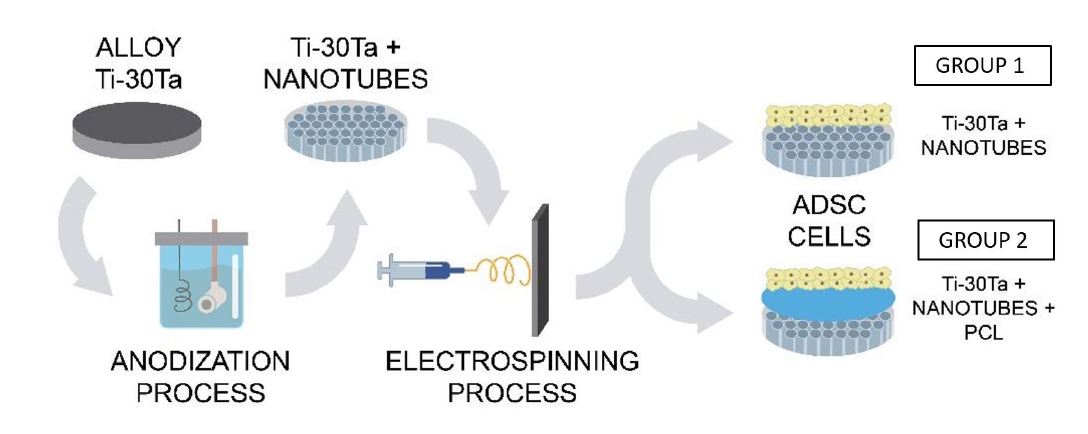
Figure 1. Methodology